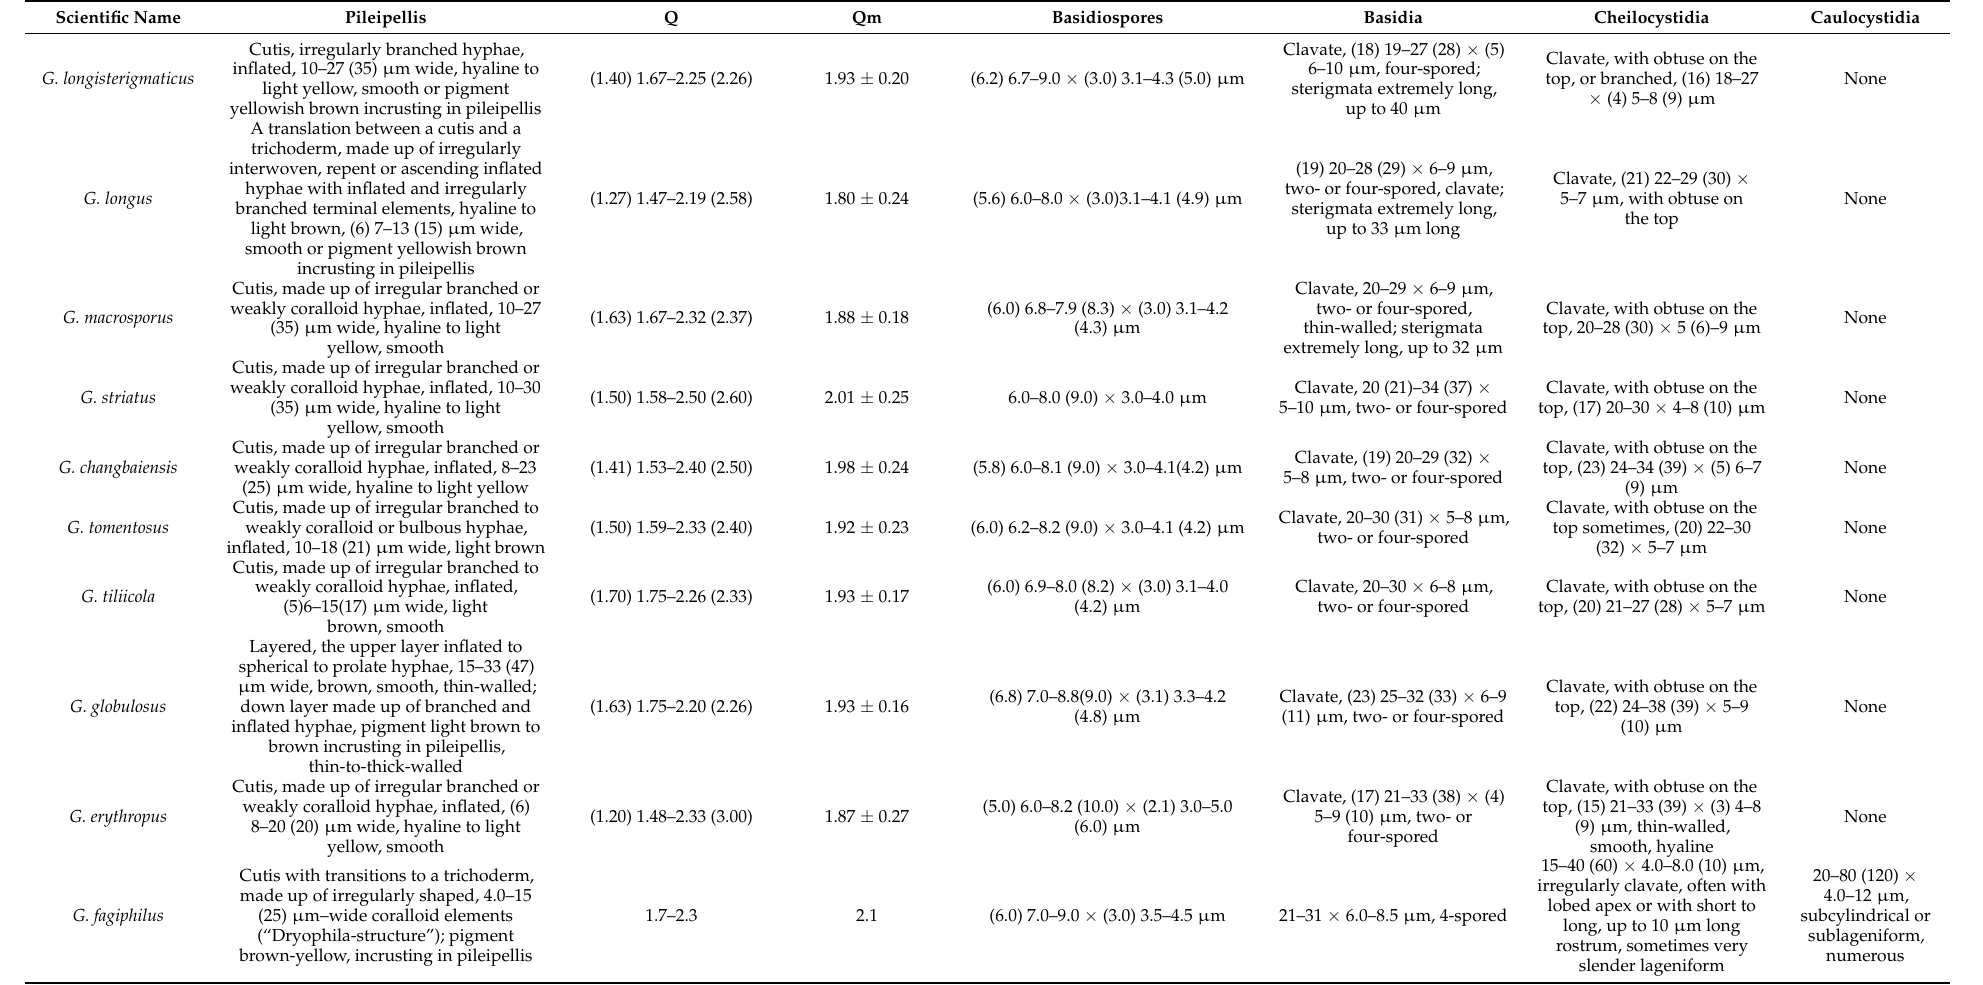
Table 3. Microcharacteristics comparison between our new species, Gymnopus erythropus and Gymnopus fagiphilus